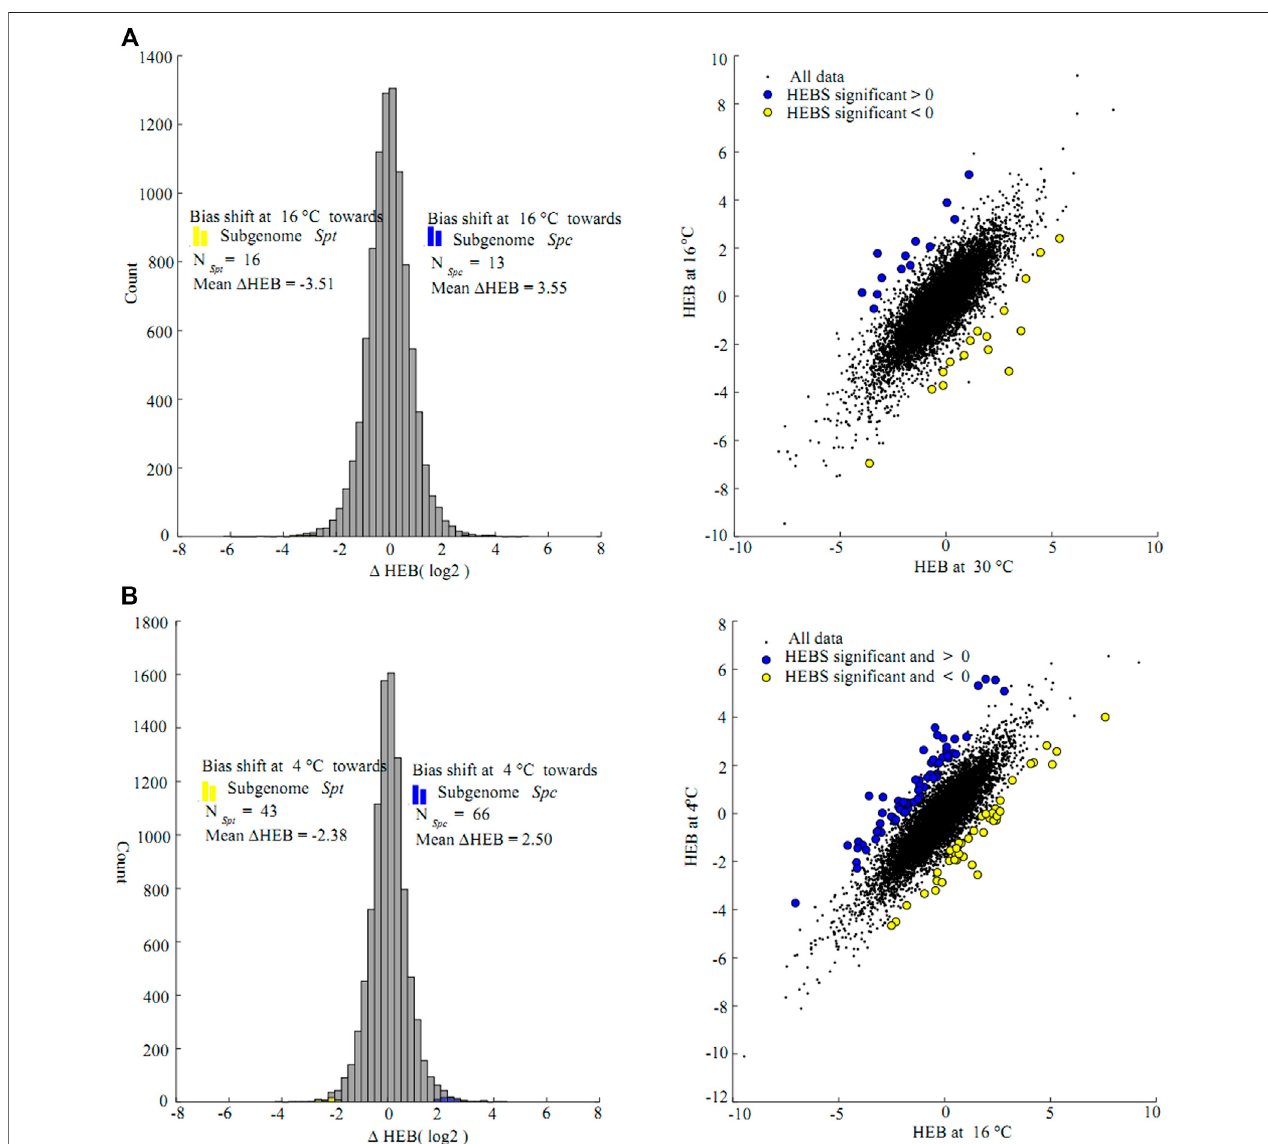
FIGURE 5 | Likelihood ratio test for changes of homeologs expression bias ( Δ HEB) between consecutive chilling stress ( (A) 16 vs . 30 ° C (B) 4 vs. 16 ° C); in the F1 hybridbetween Sphagneticolatrilobata and S.calendulacea .Histogram plotshowthedistributionof Δ HEB,andthecountsofhomeologpairsbiasedtoward S.trilobata and S. calendulacea marked using blue and yellow histogram respectively; scatter plot of Δ HEB were corresponding to the left histograms. Gene pairs with statistically signi fi cant changes in homeolog expression bias marked using the same colors as in the right histograms. Data points in the top-left and bottom-right quadrants representhomeologswherethedifferenceinthebiasfavorsdifferenthomeologsattwochillingstresstemperatures.Thetop-rightandbottom-leftquadrantscorrespond to homeologs where the difference in bias favors the same homeolog.